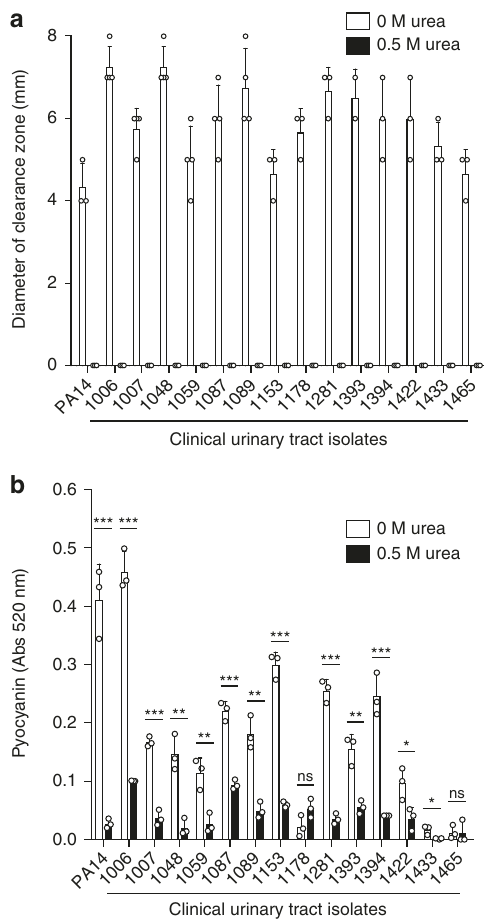
Fig. 5 Urea suppresses quorum-sensing phenotypes in P. aeruginosa UTI clinical isolates. a Diameter of clearing around colonies for a selection of P. aeruginosa UTI clinical isolates grown on milk plates supplemented with either no urea (white bars) or 0.5 M urea (black bars). Under these conditions, none of the clinical isolates had elastase activity when grown in media containing 0.5 M urea. All comparisons between no urea and 0.5 M urea have a p < 0.001. b UTI strains grown in the presence and absence of 0.5 M urea were assessed for pyocyanin production. Data represent the mean and standard deviation of at least three independent samples. Data were analyzed by unpaired t -test using GraphPad Prism software by comparing samples with no urea or 0.5 M urea. Asterisk (*, **, and ***) indicates p < 0.05, 0.01, and <0.001, respectively and "ns" indicates